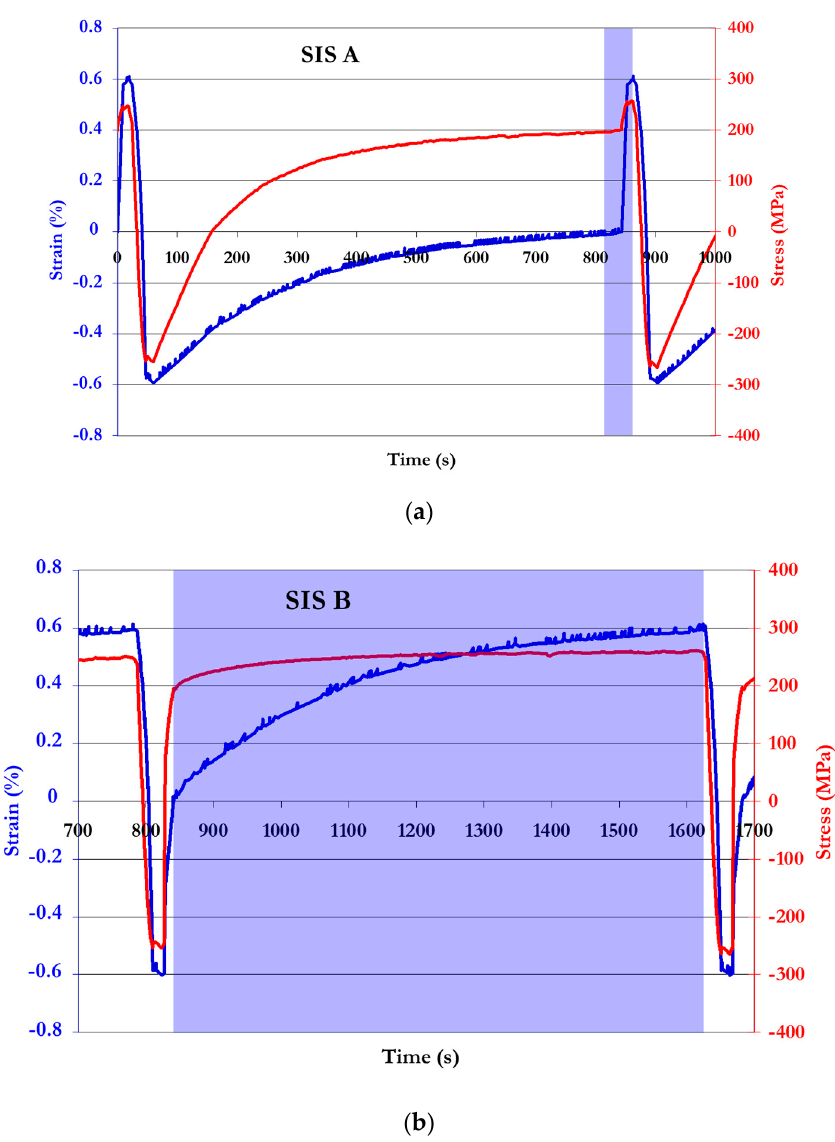
Figure 15. Representation of the T * time in the SIS A and in SIS B signals.